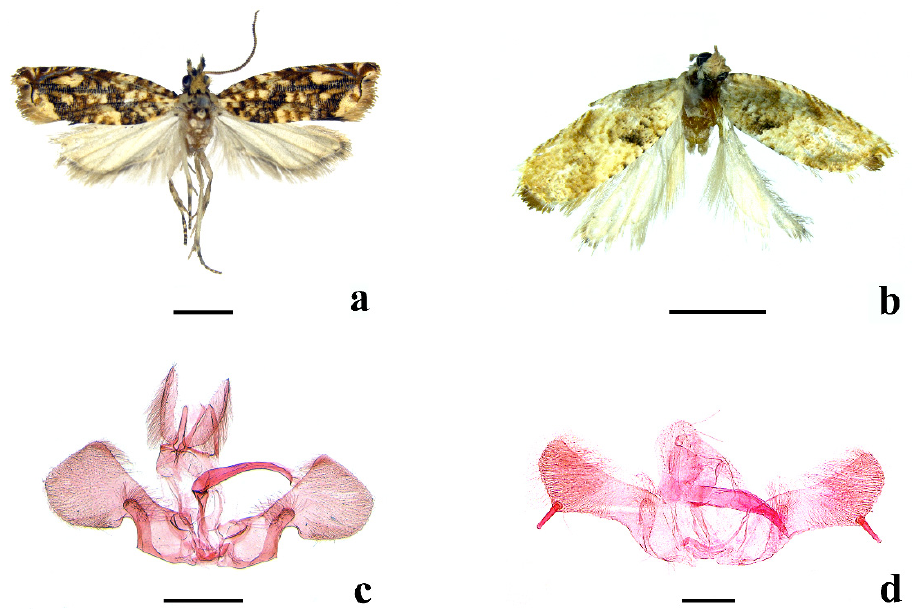
Figure 1. Rhopalovalva spp. ( a ). Adult of R. stilliformis sp. nov., holotype; ( b ). Adult of R. spinata sp. nov., holotype; ( c ). Male genitalia of R. stilliformis sp. nov., holotype, slide no. ZAH19011; ( d ). Male genitalia of R. spinata sp. nov., holotype, slide no. ZAH19014 (Scale bars: a , b = 2 mm; c = 0.5 mm; d = 0.2